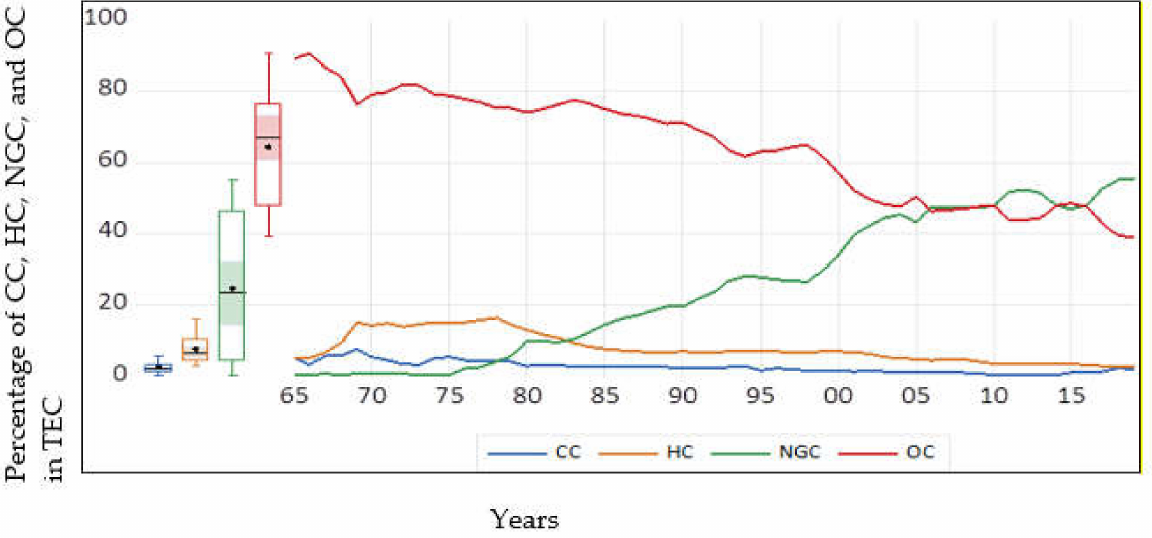
Figure 2. Trends of Energy